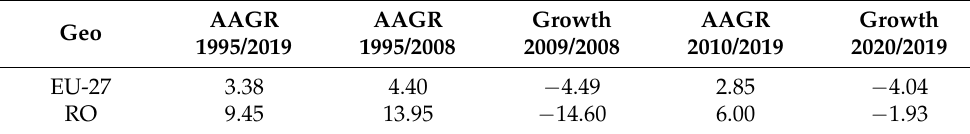
Table 1. Analysis of GDP evolution from 1995 to 2020.